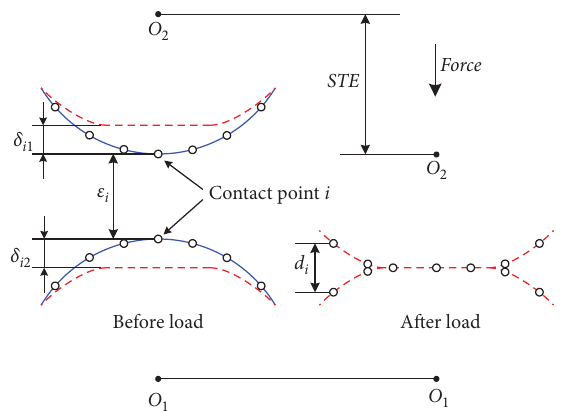
Figure 4: Instantaneous contact model for a modified helical gear pair with mesh misalignment.